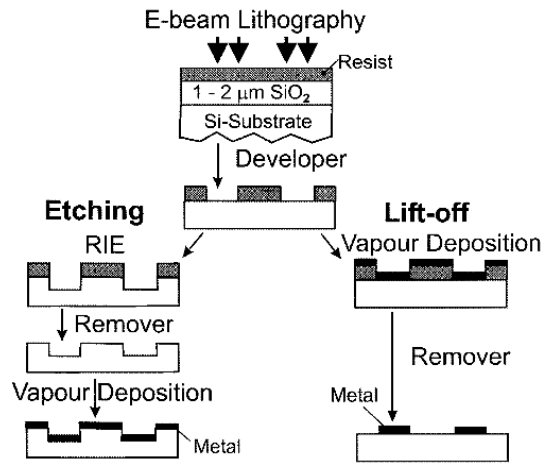
Figure 33. Steps involved in the electron beam lithography (EBL) fabrication. Reproduced with